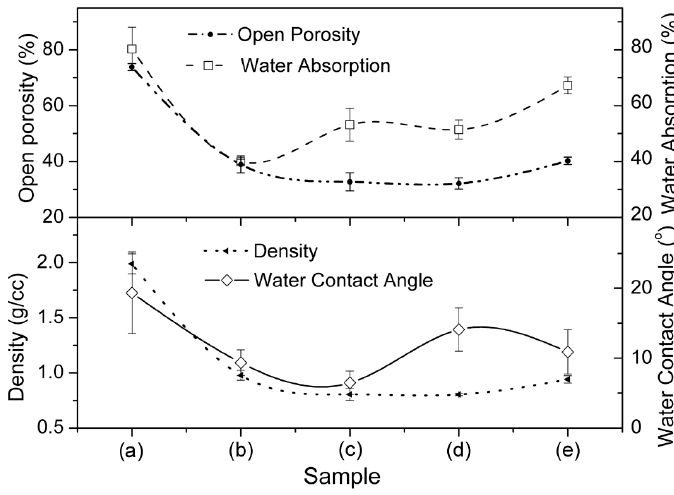
Figure 4. Density, open-porosity, water absorption and water contact angle (WCA) of ( a ) unsintered and sintered at ( b ) 450 ° C, ( c ) 650 ° C, ( d ) 850 ° C and ( e ) 1050 ° C ceramic samples.